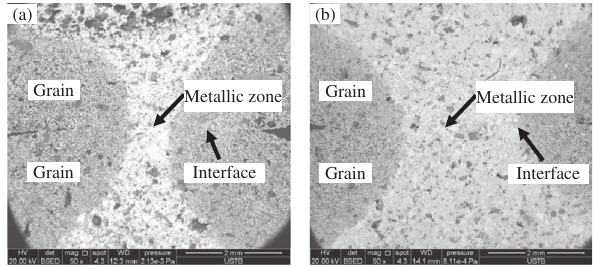
Figure 6: The interface structure of pellet particle at 10% shrinkage rate. (a) General; (b) high reduction potential.